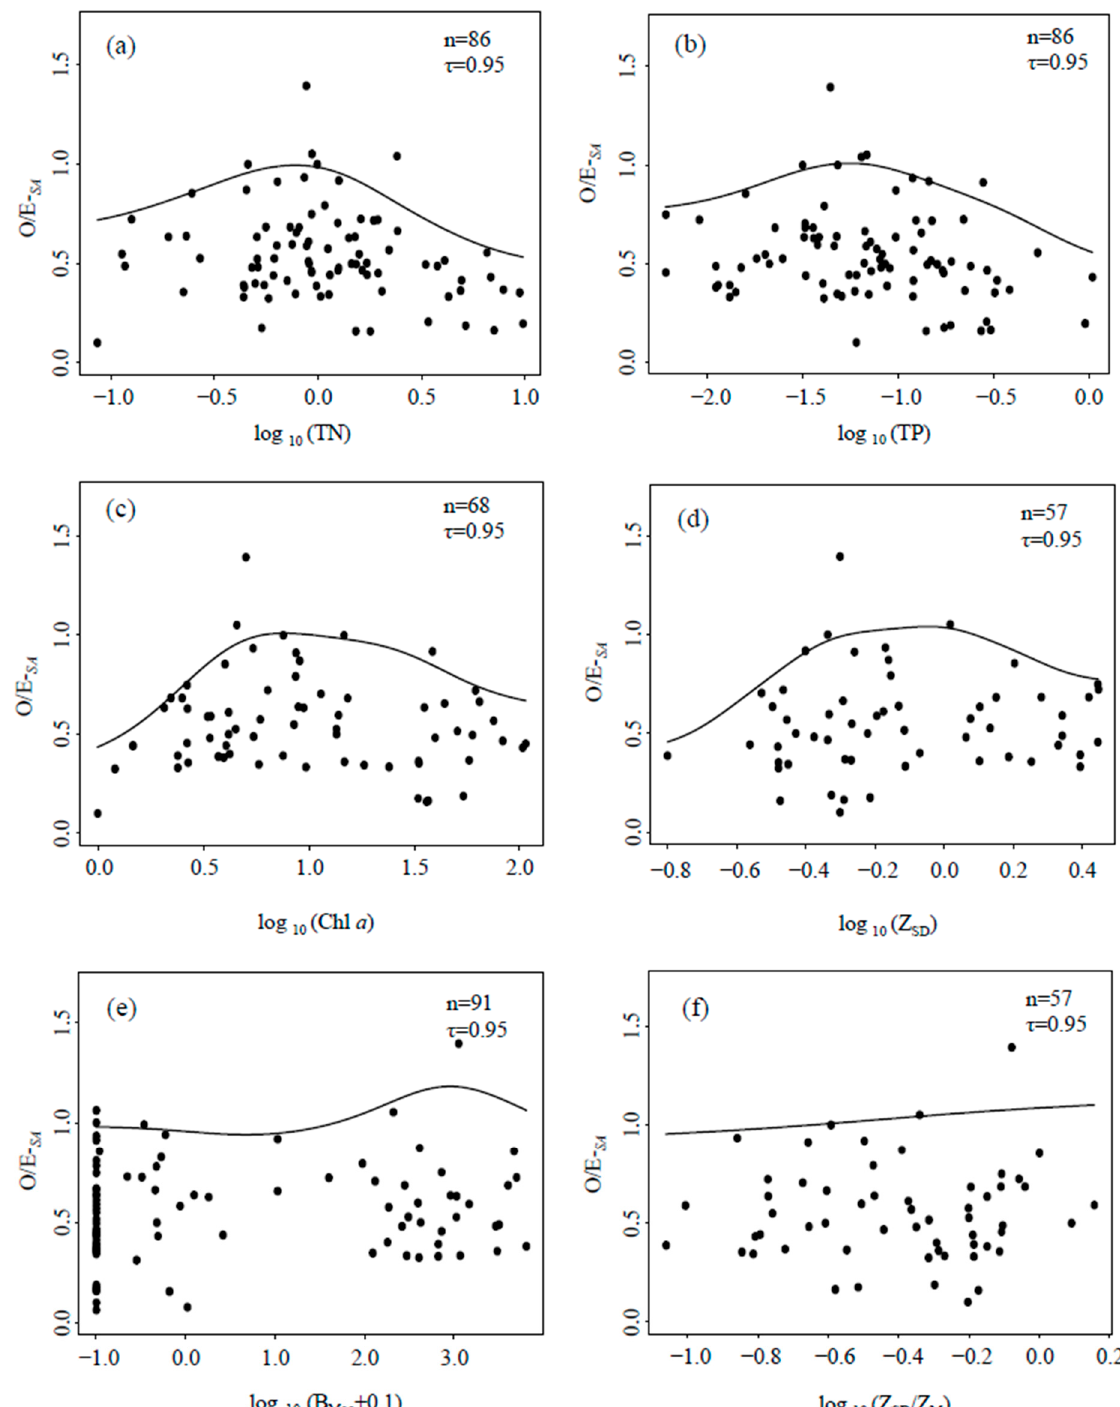
Figure 4. Quantile regressions of O/E- SA on total nitrogen (TN, mg/L) ( a ), total phosphorus (TP, mg/L) ( b ), phytoplankton chlorophyll a (Chl a , μ g/L) ( c ), Secchi depth (Z SD , m) ( d ), submersed macrophytes biomass (B Mac , g/m 2 ) ( e ), and the ratio of Secchi depth to water depth (Z SD /Z M , m) ( f ). (n differs because of environmental data deficient).